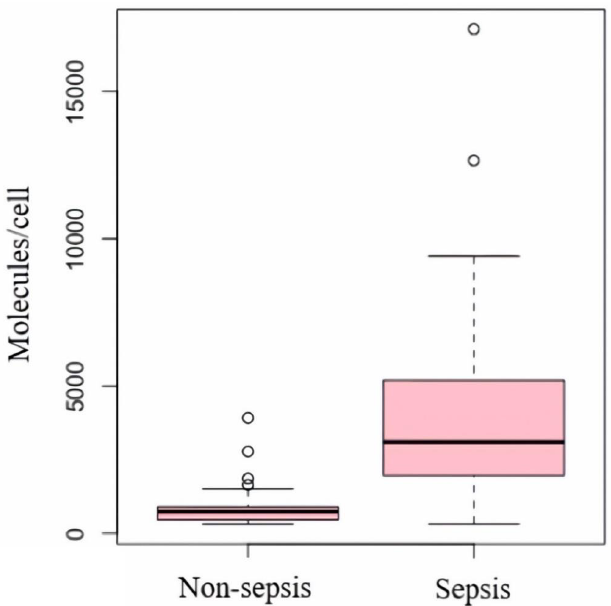
Figure 2. Box plot of the distribution of nCD64 values in the sepsis and non-sepsis groups. Table 2. Distributions of levels of nCD64, PCT, and WBC in the sepsis and non-sepsis groups.